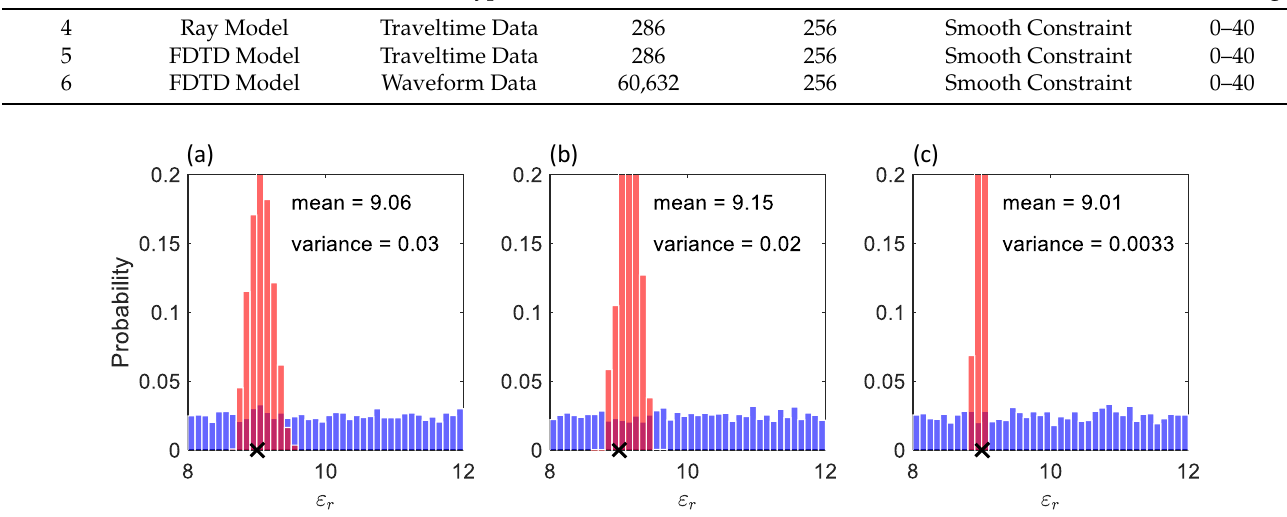
Figure 11. Histograms of the prior (blue bars) and posterior (red bars) distribution of three randomly selected parameters derived from Bayesian inversion with smooth model constraint using ( a ) the straight-ray forward model with first-arrival traveltime data, ( b ) FDTD model with first-arrival traveltime data, and ( c ) FDTD model with waveform data. The true values of the parameters are denoted with black